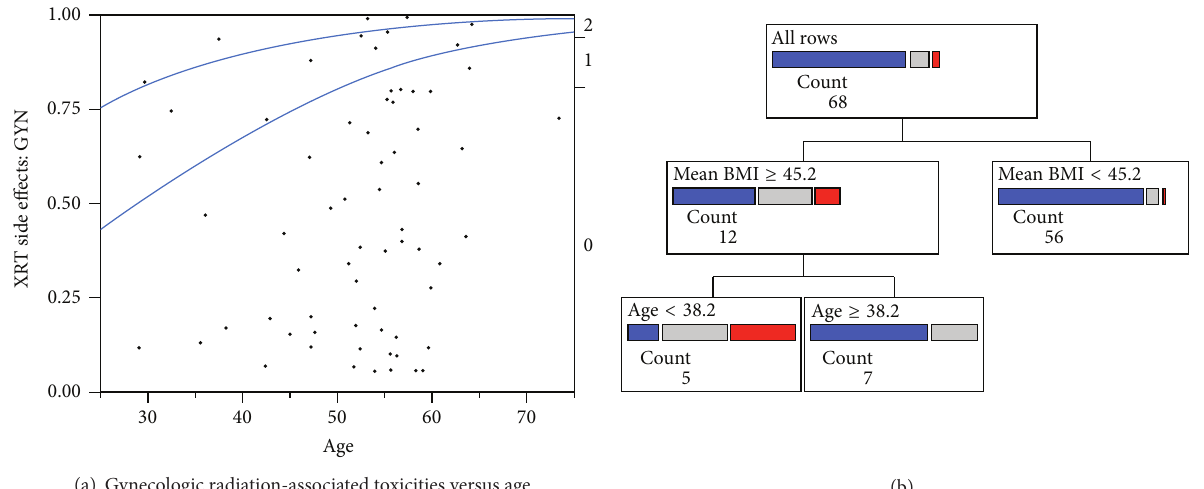
Figure 2: Frequency of acute gynecologic toxicities in relation to both age and mean BMI. (a) Logistic regression curve modeling acute gynecologic toxicities versus age. (b) Recursive partitioning analysis showing that gynecologic-associated toxicities increase in patients with mean BMI > 45.2 mg/m 2 and age < 38 years (blue = grade 0, grey = grade 1, and red = grade 2; count = number of patients in each